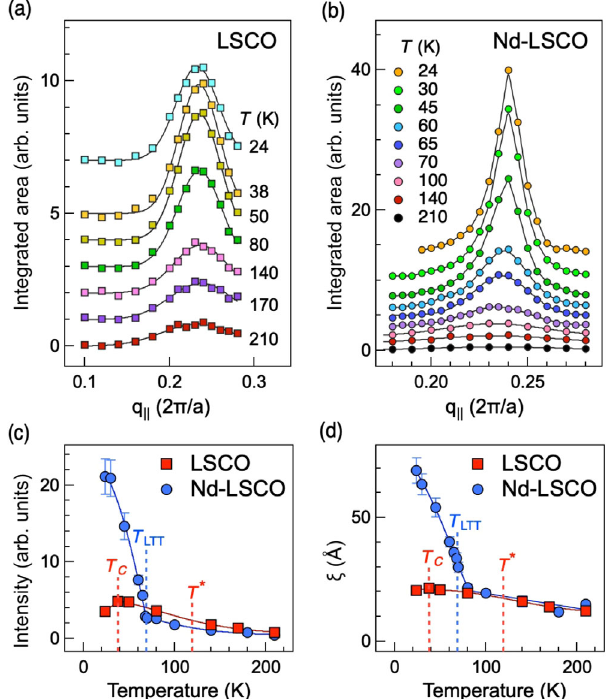
FIG. 1. O K -edge elastic scattering of La-214 cuprates. (a),(b) Scattering intensities of LSCO and Nd-LSCO vs in-plane momentum q k along the antinodal direction ð π ; 0 Þ at various temperatures. Energy-resolved elastic-scattering plots are ex- tracted from the integrated area of O K -edge RIXS over the energy from − 5 to 5 meV. The incident x-ray energy for the RIXS spectra is tuned to the mobile hole of the so-called Zhang-Rice singlet (ZRS) with an absorption energy near 528.5 eV. All spectra are vertically offset for clarity. (c),(d) CDW intensity and correlation length ( ξ ) of LSCO and Nd-LSCO as a function of the temperature, respectively. The vertical dashed lines show T and T (cid:1) of LSCO and structural transition temperature T Nd-LSCO. All solid lines serve as visual